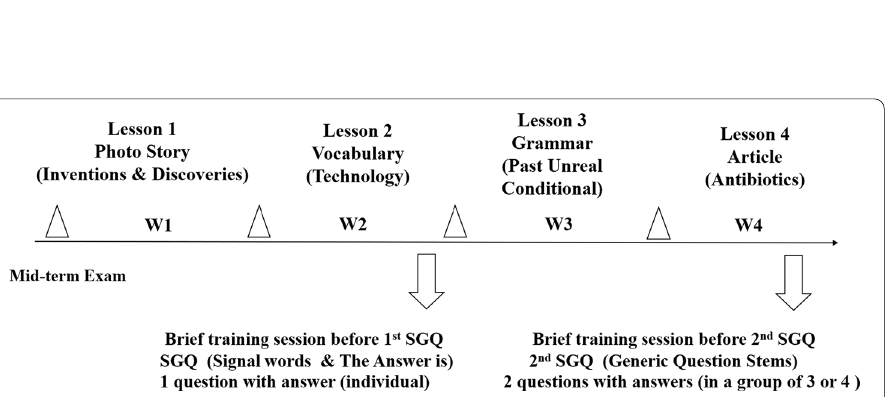
Fig. 3 The experimental procedure for the SGQ activities in the